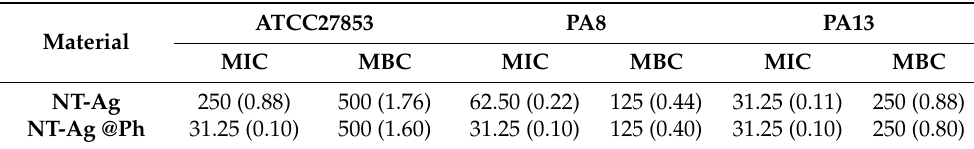
Table 3. Minimum inhibitory concentration (MIC) and minimum bactericidal concentration (MBC) for NT-Ag and NT-Ag@Ph against three different planktonic P. aeruginosa strains. Data are given in µ g/mL of material, and data in parentheses refer to the µ g/mL of silver.